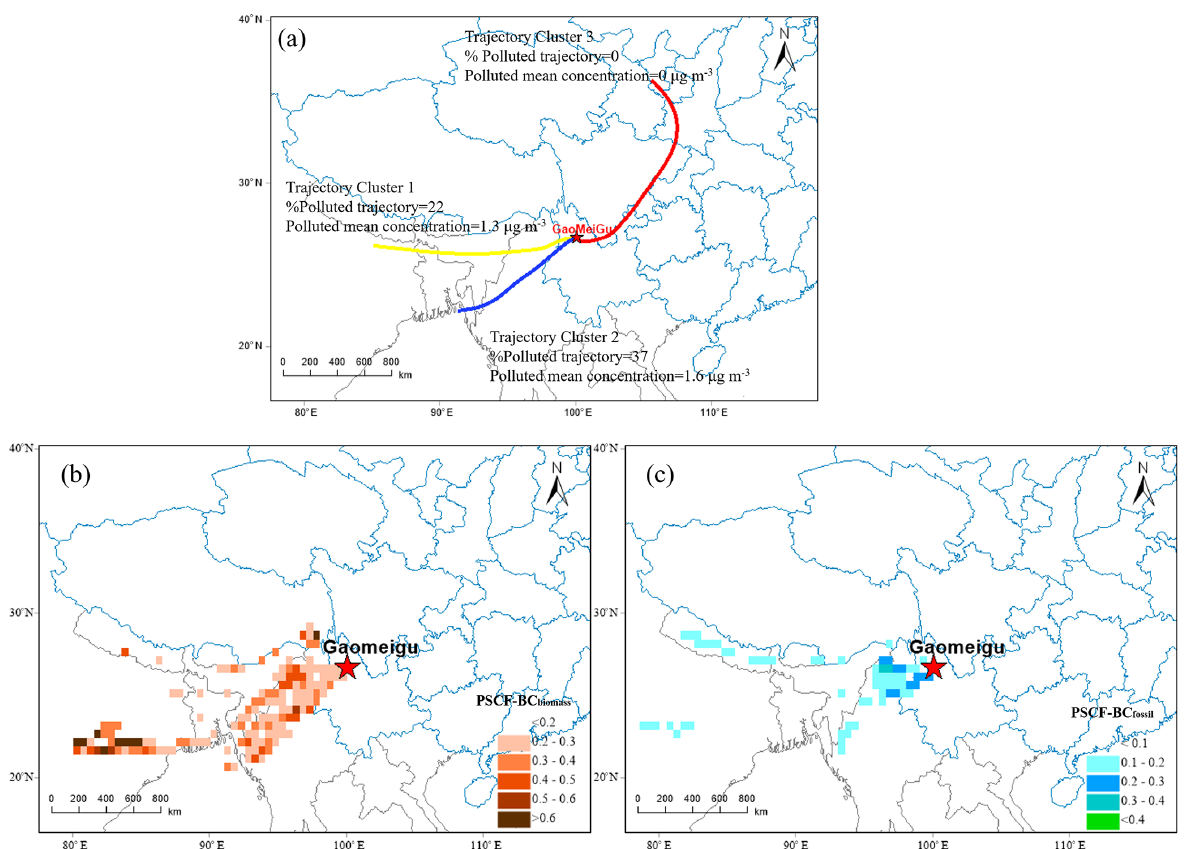
Figure 5. Maps of (a) the mean trajectory clusters, (b) the potential source contribution function for black carbon (BC) aerosol from biomass burning (BC biomass ) and (c) from fossil fuel sources (BC fossil